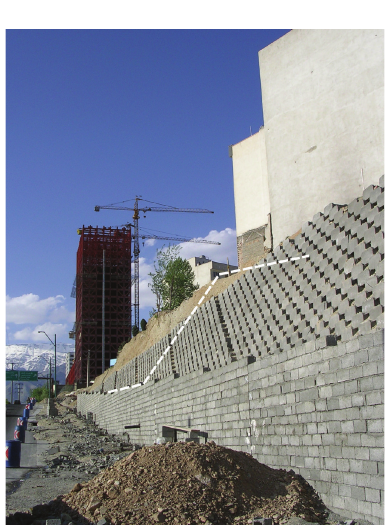
Figure 5: Geometry of backfill behind a retaining wall, Tehran, Iran.